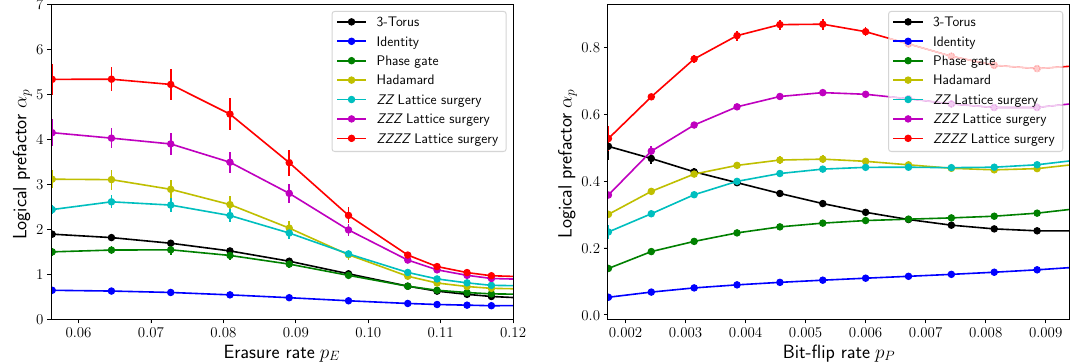
FIG. 27. Estimated fits of the logical prefactor α p to the logical block error rate P p ( d ) = α p e − β p d under IID erasure and IID bit-flip noise models for the identity, 3-torus, phase, Hadamard, and multiqubit lattice surgery blocks.